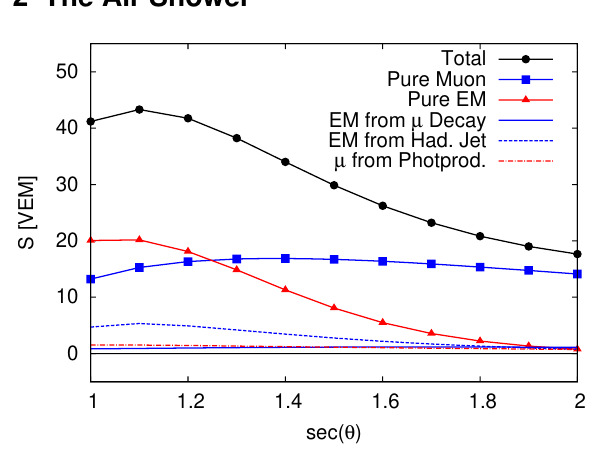
Figure 2. The contributions of di ff erent components to the av- erage signal as a function of zenith angle, for stations at 1 km from the shower core, in simulated 10 EeV proton air showers illustrated for